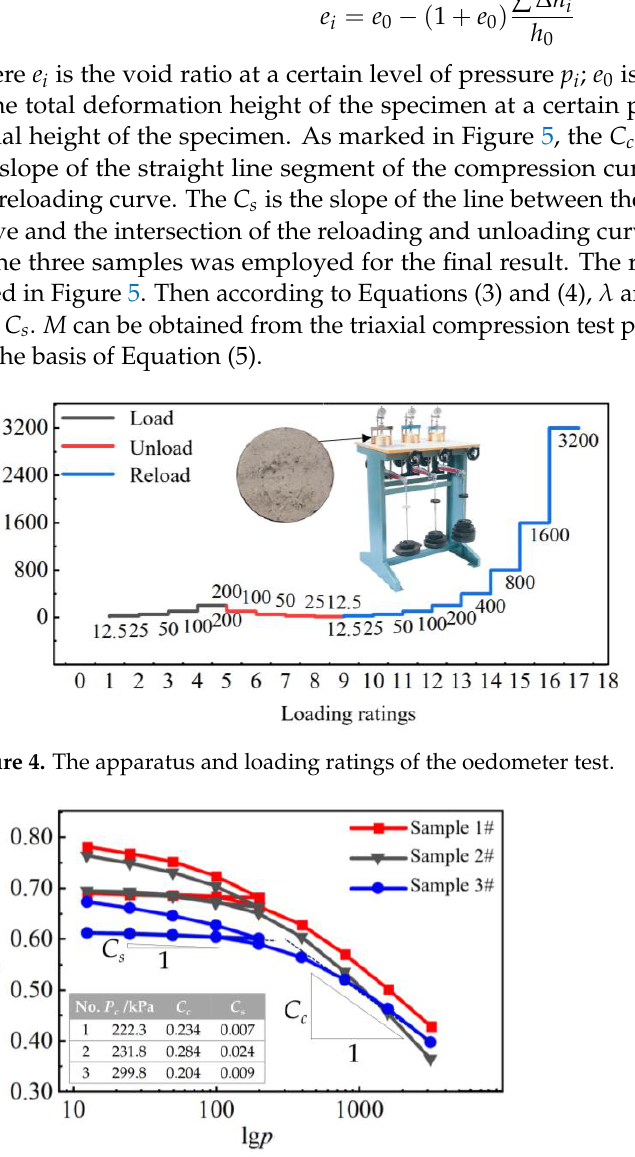
Table 1. Physical and mechanical parameters of silt for the excavation.